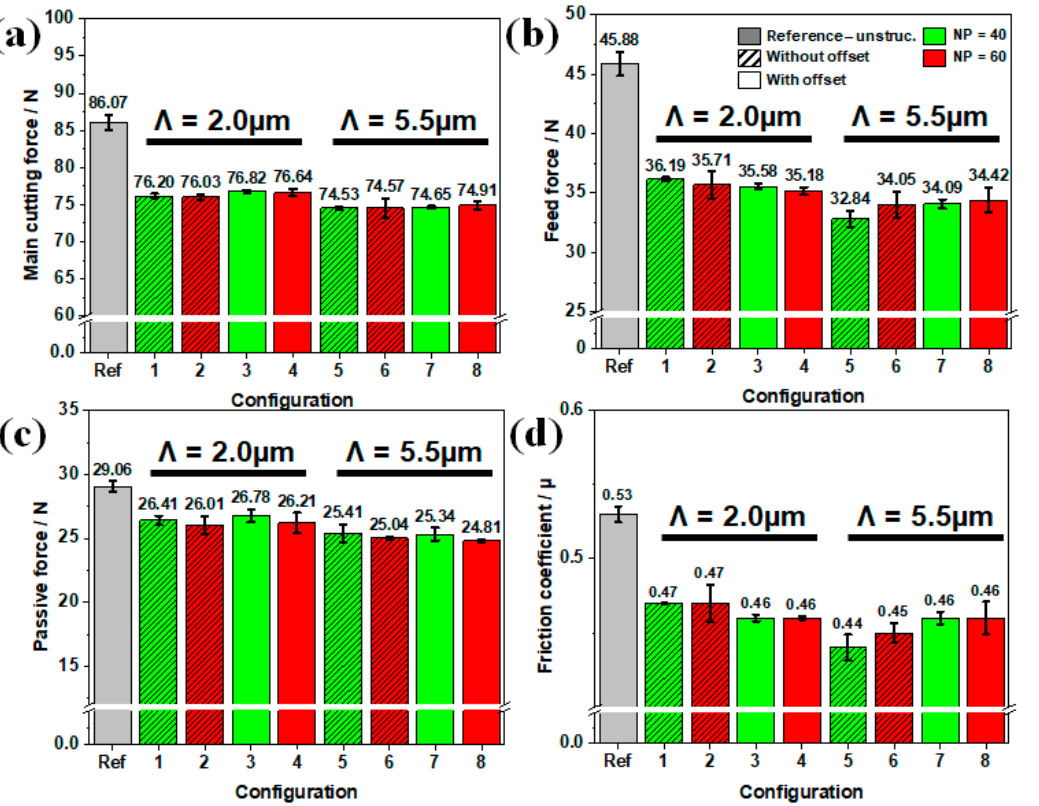
Figure 4. Machining forces evaluation for different configurations (conventional tool (Ref), (1–4) textured tools with Λ of 2 µ m and (5–8) textured tools with Λ of 5.5 µ m: ( a ) Main cutting force F c , ( b ) feed force F f , ( c ) passive force, and ( d ) the calculated friction coefficient µ .